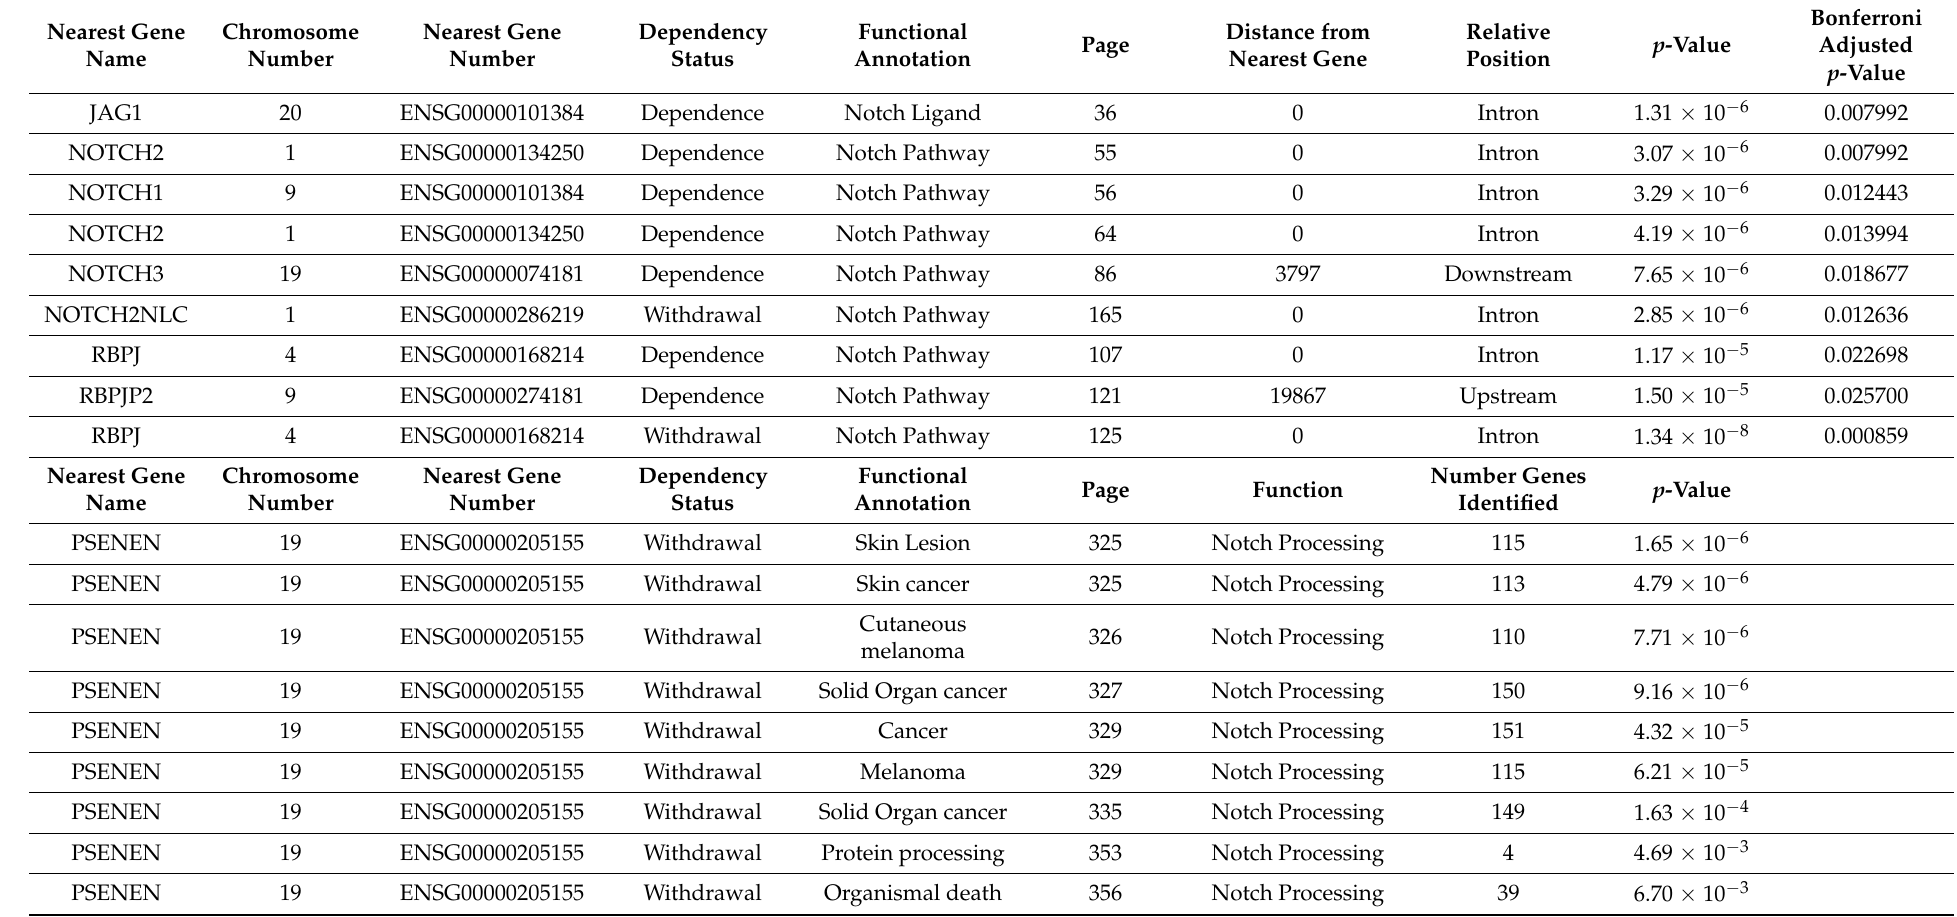
Table 17. EWAS Hits from Schrott Dataset for Significantly Differentially Methylated Regions for.Notch